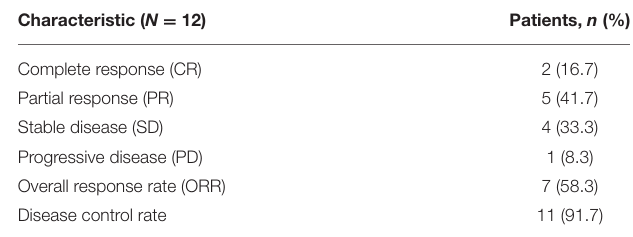
TABLE 1 | Patient characteristics. TABLE 2 | Best response by